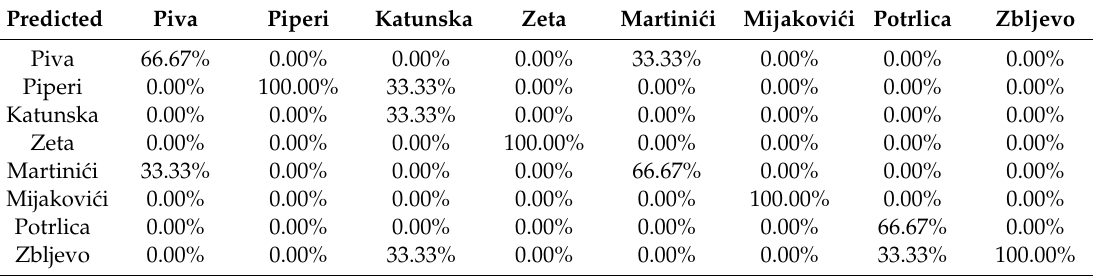
Table 3. Classification of honey according to their regional origin using the linear discriminate analysis.